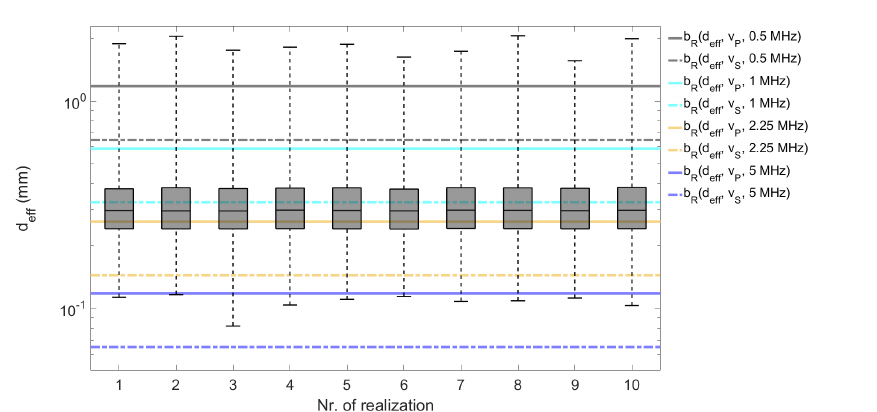
Figure 12. Effective cell diameters in ten realizations of the Inconel-617 microstructure model. The solid and dashed horizontal lines correspond to the upper boundaries of the Rayleigh regime for the pressure and shear waves, respectively. Colors code the frequency, see legend. Clearly, the Rayleigh regime is violated in the 5 MHz